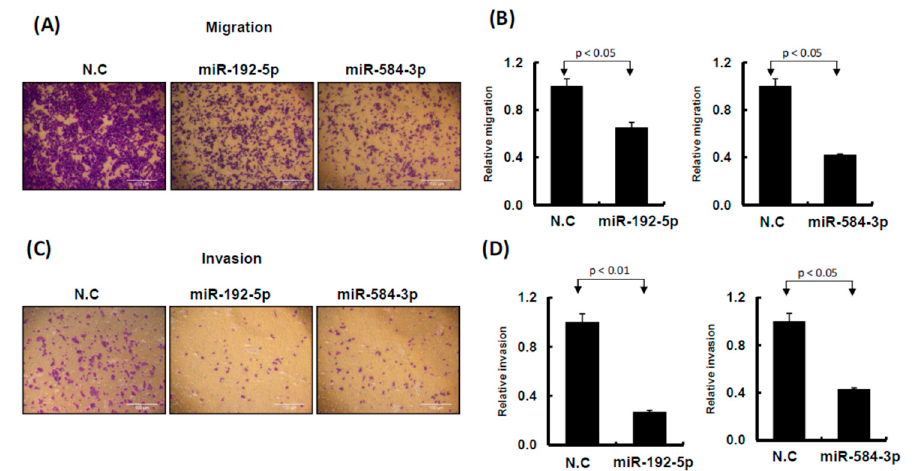
Figure 6. miR-192-5p and miR-584-3p influenced cell invasion ability of melanoma cells. ( A ) and ( C ): Migration and invasion ability were examined by Transwell assay in A2058 cells. After miR-192-5p, miR-584-3p mimics, or scramble control transfection for 24 h, cells were subjected to Transwell assay. Migrating and invading cells were stained with crystal violet solution. ( B ) and ( D ): Numbers of migrating or invading cells were quantified by counting three different fields under a phase-contrast microscope. The cell photographs from a representative experiment are depicted and the graph data were quantified using Ascent software. Data are reported as colonies compared with control (means ± SD).